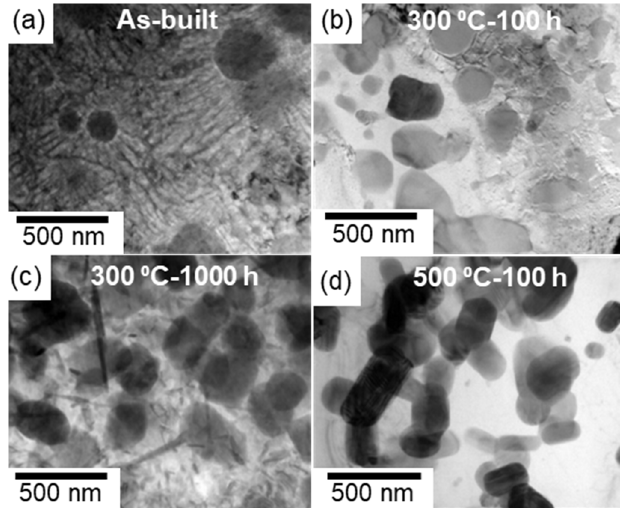
Figure 4. TEM images showing microstructures in the melt pools of the ( a ) as-built and ( b – d ) ther- mally treated L-PBF-built Al–15%Fe alloy samples: ( b ) 300 °C/100 h, ( c ) 300 °C/1000 h, and ( d ) 500 °C/100 h.